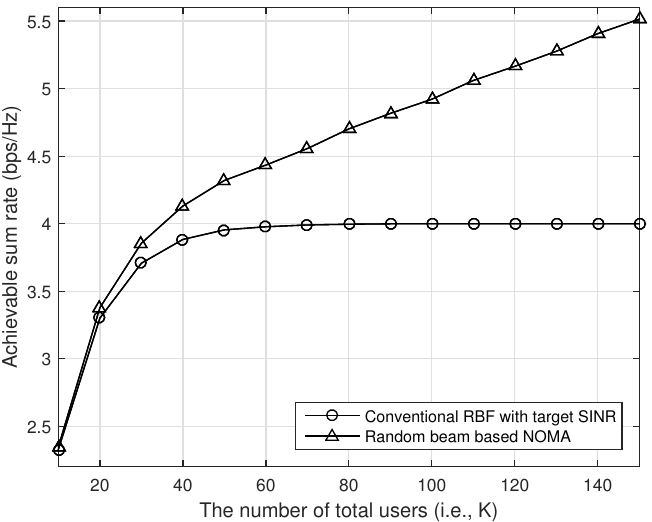
Figure 2. The performance of our proposed random beam-based NOMA with respect to the number of users when the transmitter has four antennas, and SNR is 10 dB.